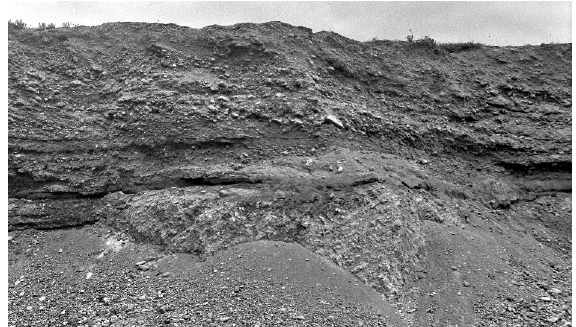
Fig. 12. Inclined bedrock strata in the distal part of Tornim(cid:228)gi Hill are covered with gravel and pebbles, which are poorly sorted and stratified. Photo by A.